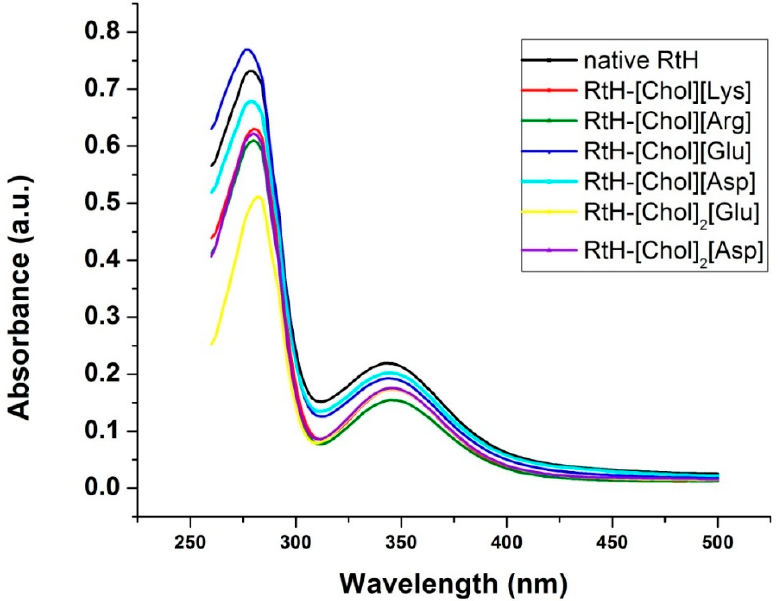
Figure 1. Absorption spectra of Rapana thomasiana hemocyanin (RtH) (0.75 mg/mL, 0.08 µM) in 50 mM phosphate buffer (pH 7.2) containing 1.25 mM [Chol] n [AA] taken after a 60-min incubation at 20 °C.